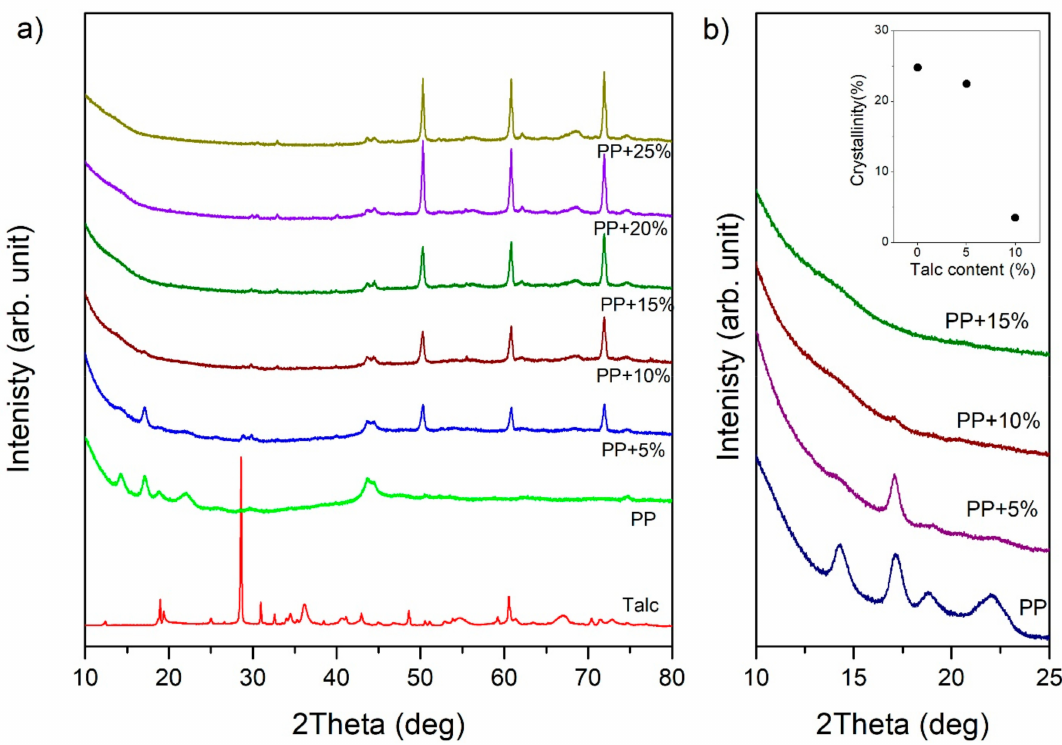
Figure 3. XRD patterns of ( a ) pure talc powder, polypropylene, and samples with di ff erent talc content and ( b ) an enlarged range of the di ff raction pattern for 2 θ from 10 ◦ to 25 ◦ . The inset presents the relation between the crystallinity degree and the talc